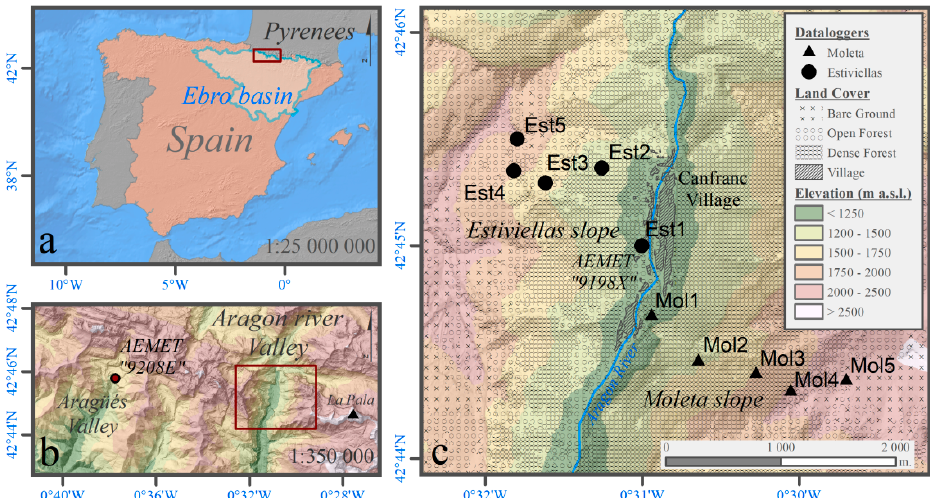
Figure 1. Geographical approximation of the local area: ( a ) represents the Iberian peninsula, in the southwest of Europe, ( b ) represents the location of the river valley in the Pyrenean context and ( c ) shows the terrain map of the local study domain, showing the Estiviellas and Moleta slopes and dataloggers located west and east of the Arag ó n River, respectively. Land cover is represented by textures as shown in the legend, and retrieved from the photointerpretation of a Sentinel-2B summer image (11 September 2019) and the help of the normalized di ff erence vegetation index band. Canfranc-Station village is located in the center of the